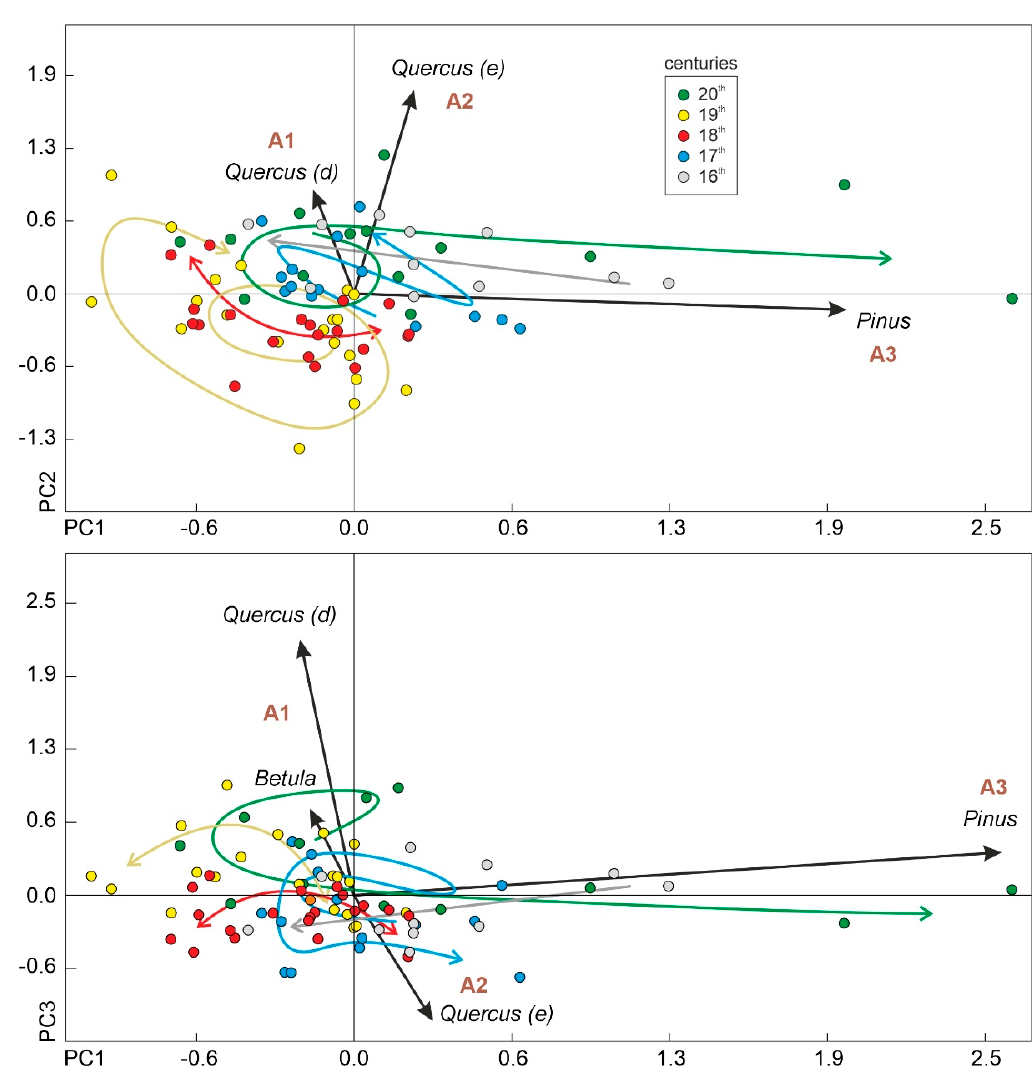
Figure 14. Euclidean biplot of the scores of the first three components of the PCA: PC1–PC2 in the upper panel and PC1–PC3 in the lower panel (see Table 3 for details on these components). Vectors corresponding to forest taxa other than Quercus , Pinus , and Betula are too small to be represented. The associations of forest taxa defined previously by cluster analysis (Figure 13) have been represented near the scores of their dominant taxa and are used as attraction domains [60]. Samples have been depicted as dots using a color code that indicates the century to which they belong. Colored arrows represent the approximate successional trajectories for each century obtained using the ages of samples and the same color code.